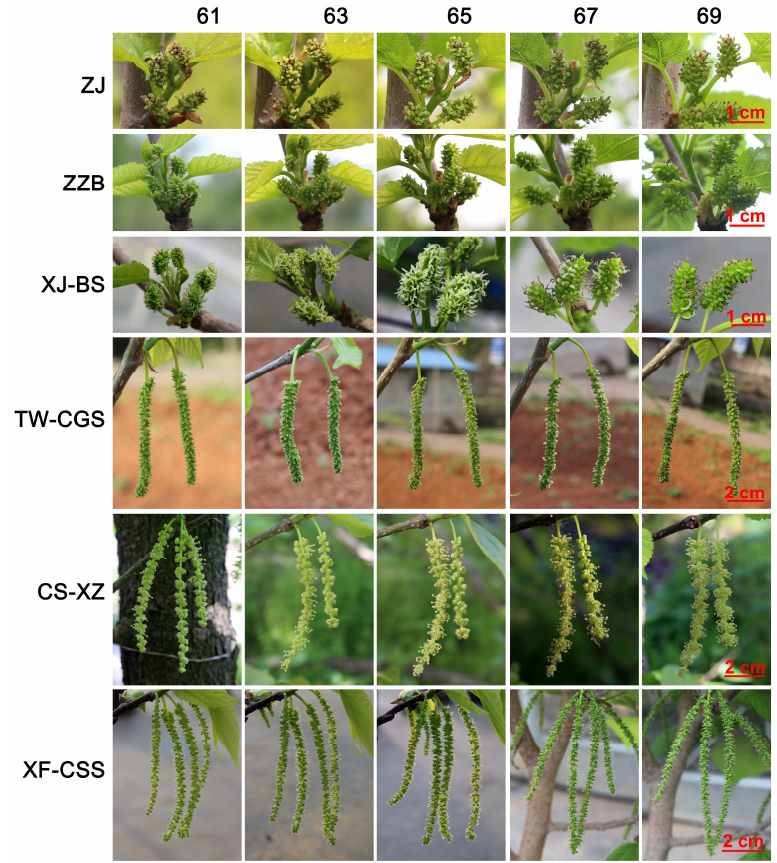
Figure 5. Flowering stages for mulberry according to the BBCH scale.